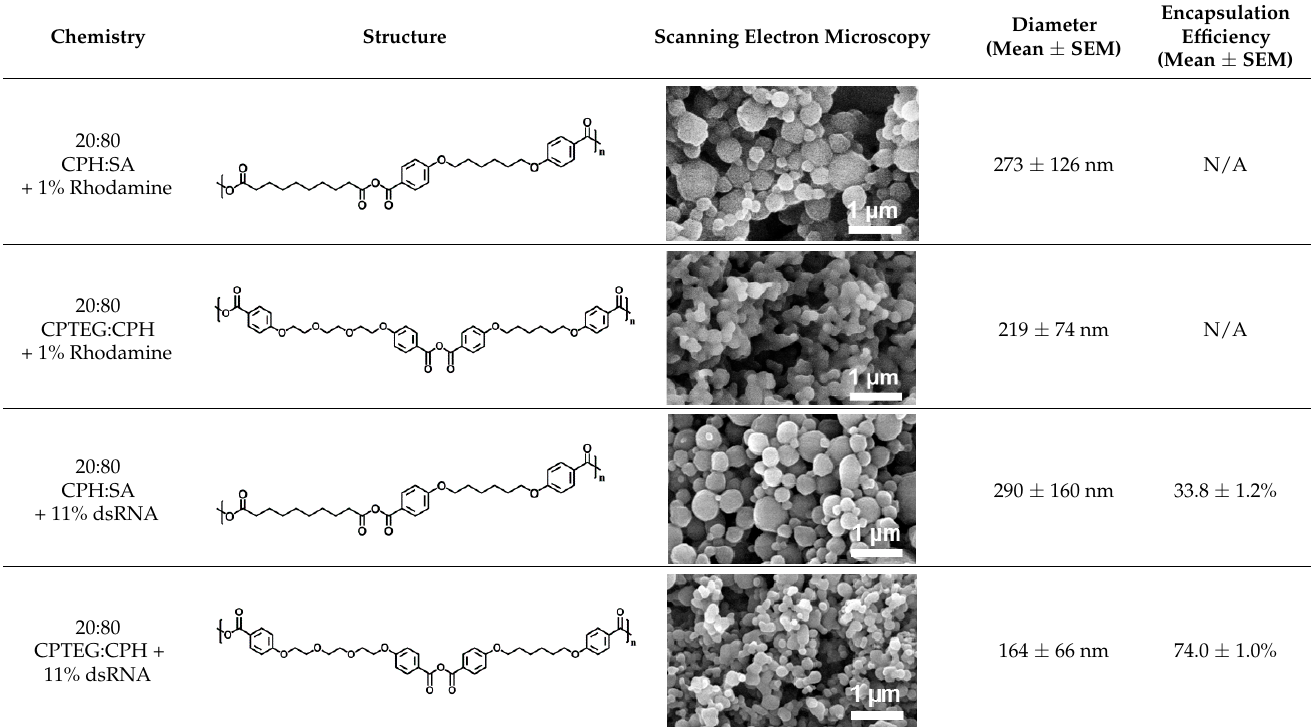
Figure 1. In vitro release kinetics of dsRNA-loaded nanoaparticles. Nanoparticles loaded with 11% WSSV 477 dsRNA were incubated in saline for approximately 1 month and the release kinetics were measured. Data are presented as the mean ± standard error of the mean (SEM) and are rep- resentative of 3 replicates per formulation.